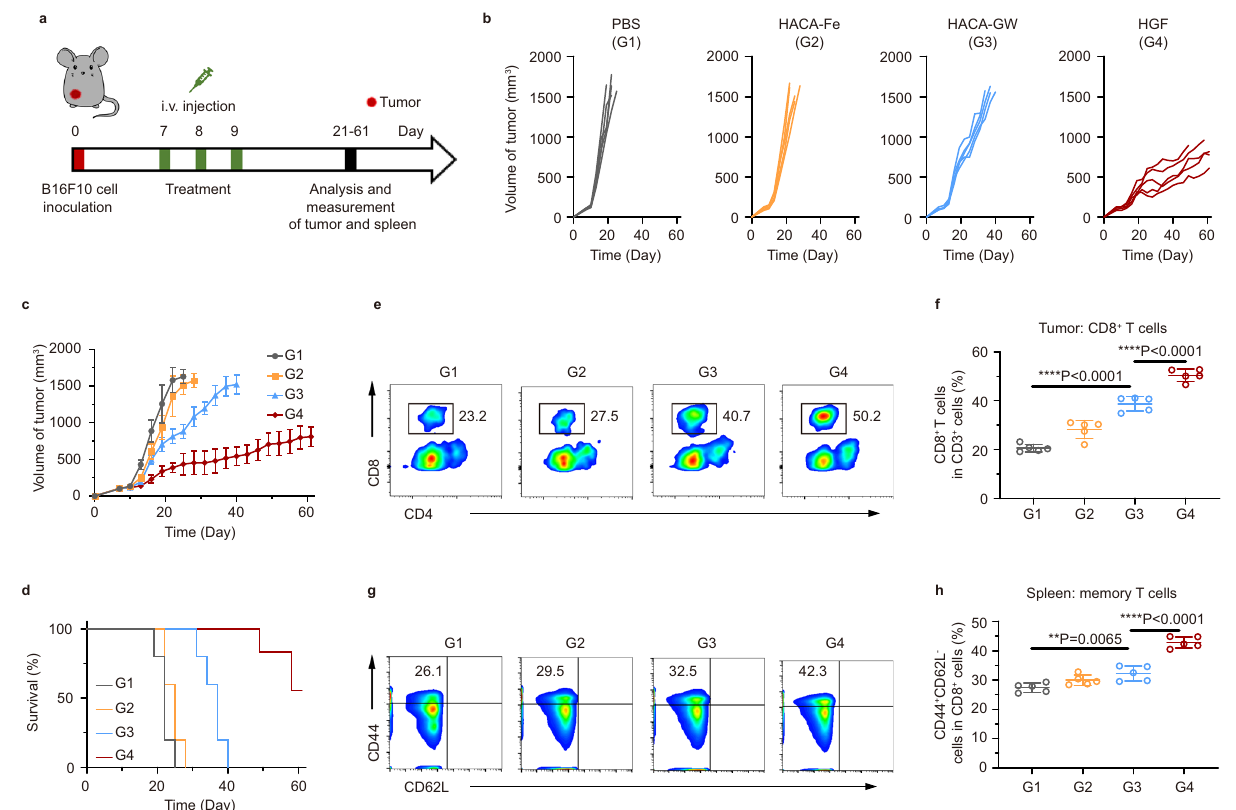
Fig. 5 HGF induced an effective therapeutic effect against B16F10 tumor. a Schematic illustration of the experiment design to assess the tumor inhibition and the immune responses as triggered by PBS, HACA-Fe, HACA-GW, or HGF NPs on subcutaneous B16F10 tumor model. G1, PBS; G2, HACA-Fe; G3, HACA-GW; G4, HGF. b and c Tumor growth curves during treatment. d Survival rates of different groups over time. e and f Representative fl ow cytometry plots and quanti fi cation of e CD8 + f and CD4 + T cells after gating on CD45 + CD3 + T cells in tumor tissue. g and h Representative fl ow cytometric analysis of memory T cells (CD3 + CD8 + CD44 + CD62L - , gated on CD3 + CD8 + T cells) in the spleen. Data were presented as mean ± SD. n = 5 biologically independent animals per group. Statistically signi fi cant differences between groups were identi fi ed by one-way ANOVA with Tukey ’ s post hoc test. * P < 0.05, ** P < 0.01, *** P < 0.001 and **** P <